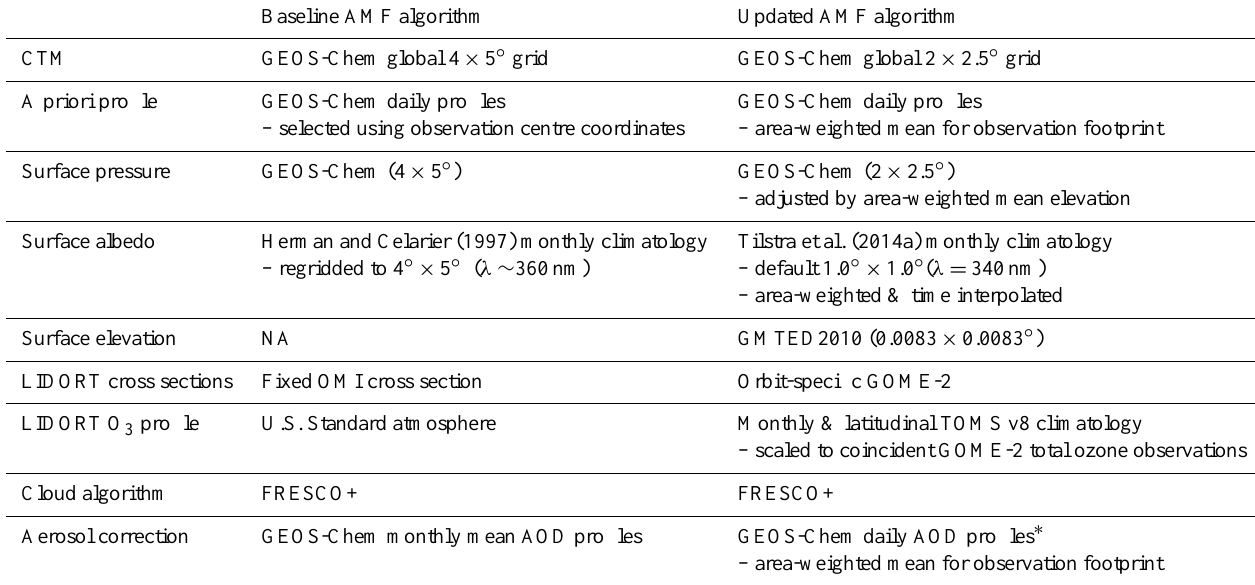
Table 3. Summary of the baseline and updated UoL AMF algorithm.